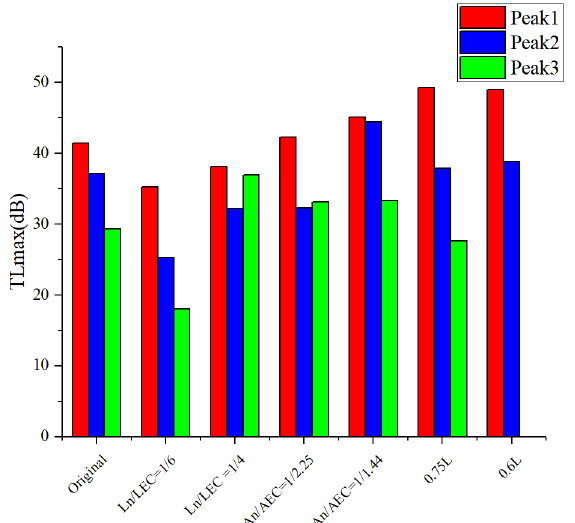
Figure 10. Variation of the transmission loss peak of the ITEC with different geometric parameters.